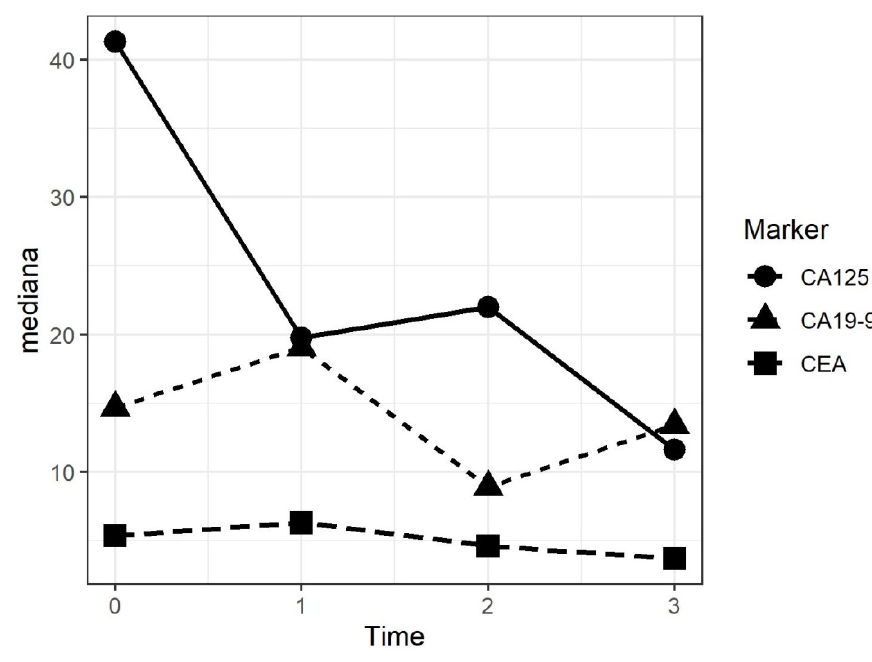
Figure 5. Progression-free survival of 20 patients with PC stratified by pathologies treated with at least two PIPAC procedures.